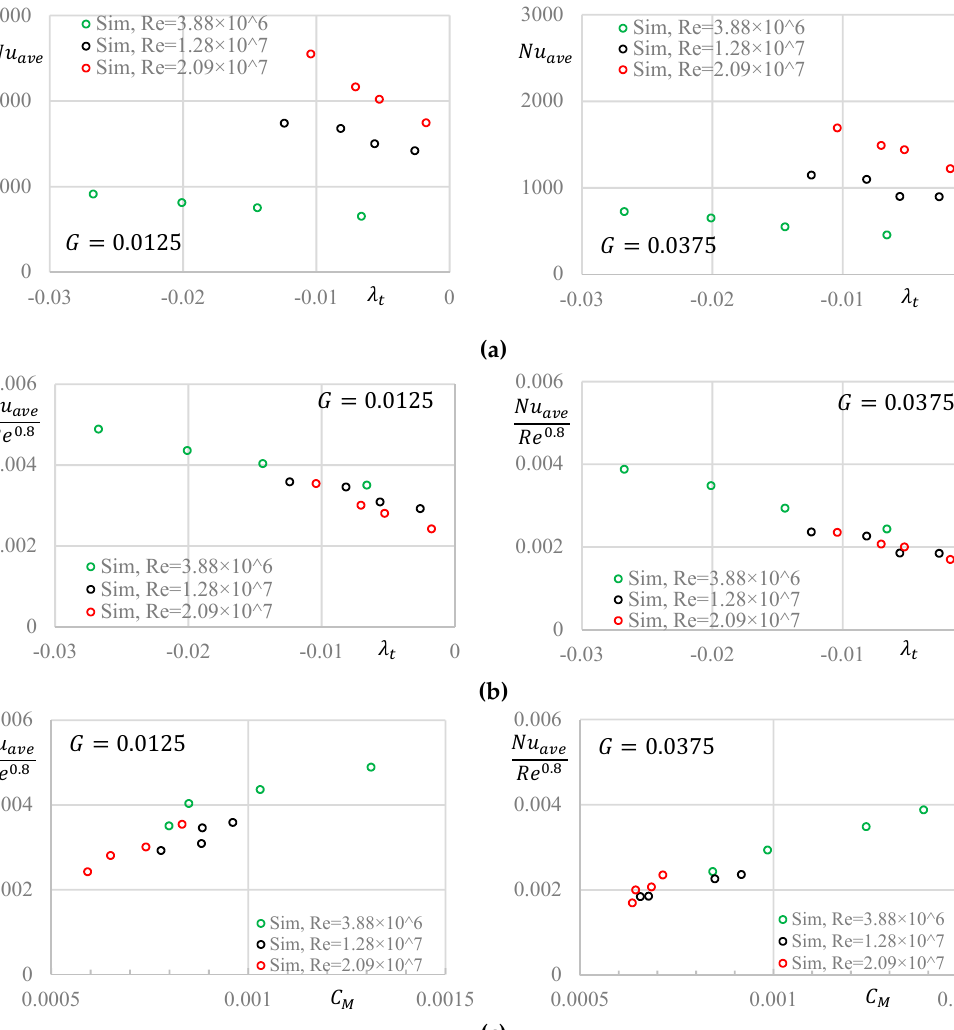
versus 𝜆 (cid:3047) versus λ t and (cid:3019)(cid:3032) (cid:3116).(cid:3124) Re 0.8